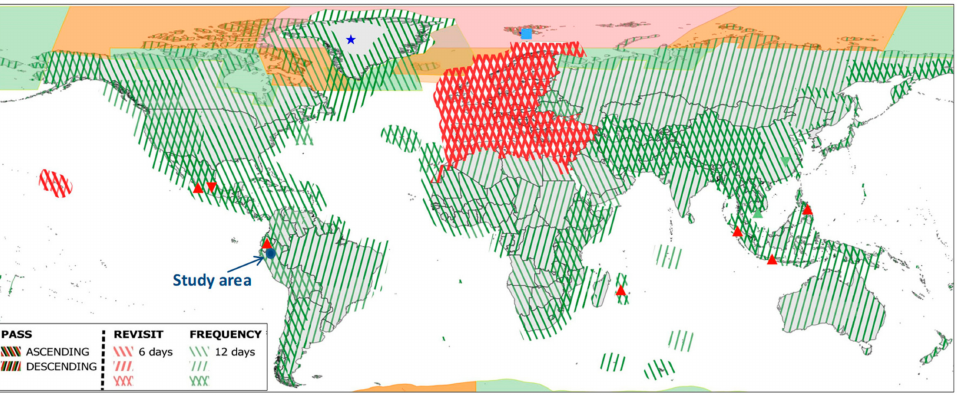
Figure 16. The Sentinel-1A and -1B observation scenario valid from February 2018 (https://sentinel.esa. int/web/sentinel/missions/sentinel-1/observation-scenario). The study site, located in Peru, is shown as a blue